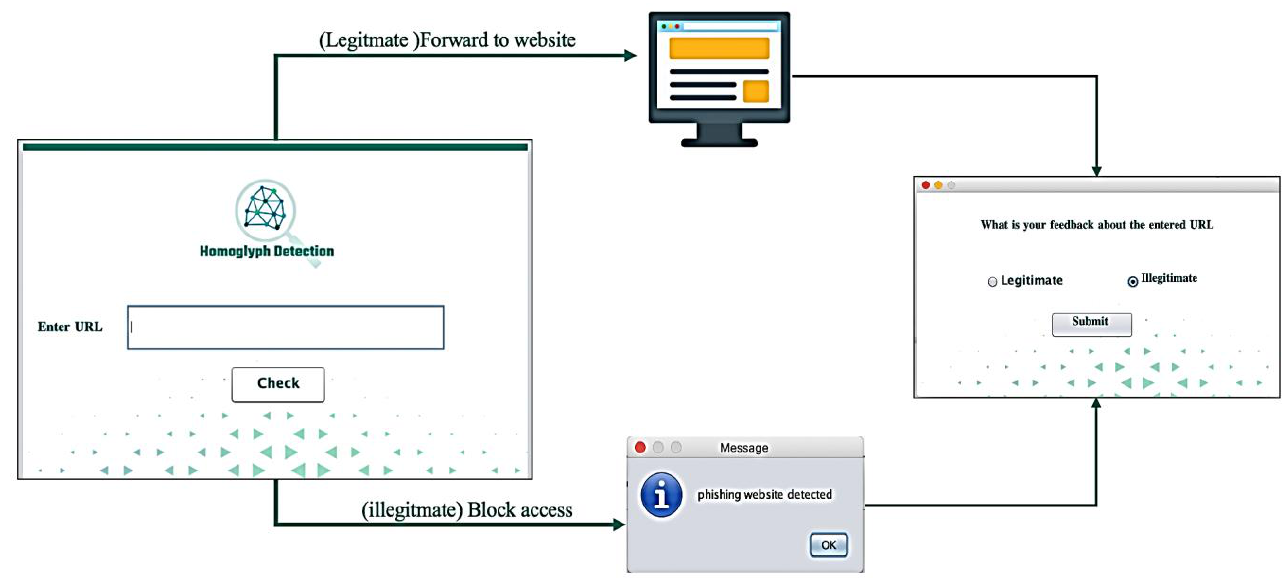
Figure 7. User access scenario.